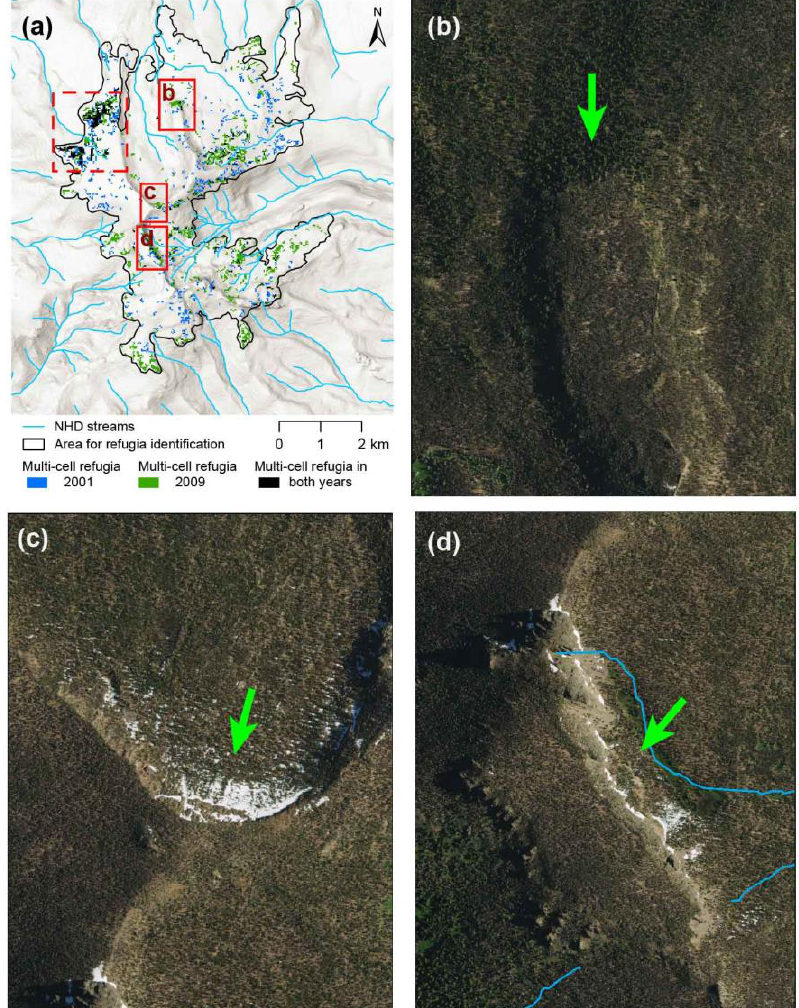
Figure 6. Examples of landforms associated with refugia. Refugia locations mapped in ( a ) included, framed in solid red boxes from north to south, ( b ) a steep north-facing slope in lodgepole pine forest, ( c ) a steep and north-facing slope in lodgepole–whitebark pine forest at the head of a cirque, and ( d ) a steep and northeast-facing slope in whitebark and lodgepole–whitebark pine forest adjacent to a riparian area. Refugia locations in the dashed red box were not associated with any discernible topographic features but were associated with low soil bulk density at 1-meter depth. All imagery is from the National Agriculture Imagery Program (NAIP), acquired 29 June, 2016. Streamlines are from the National Hydrography Dataset (NHD).